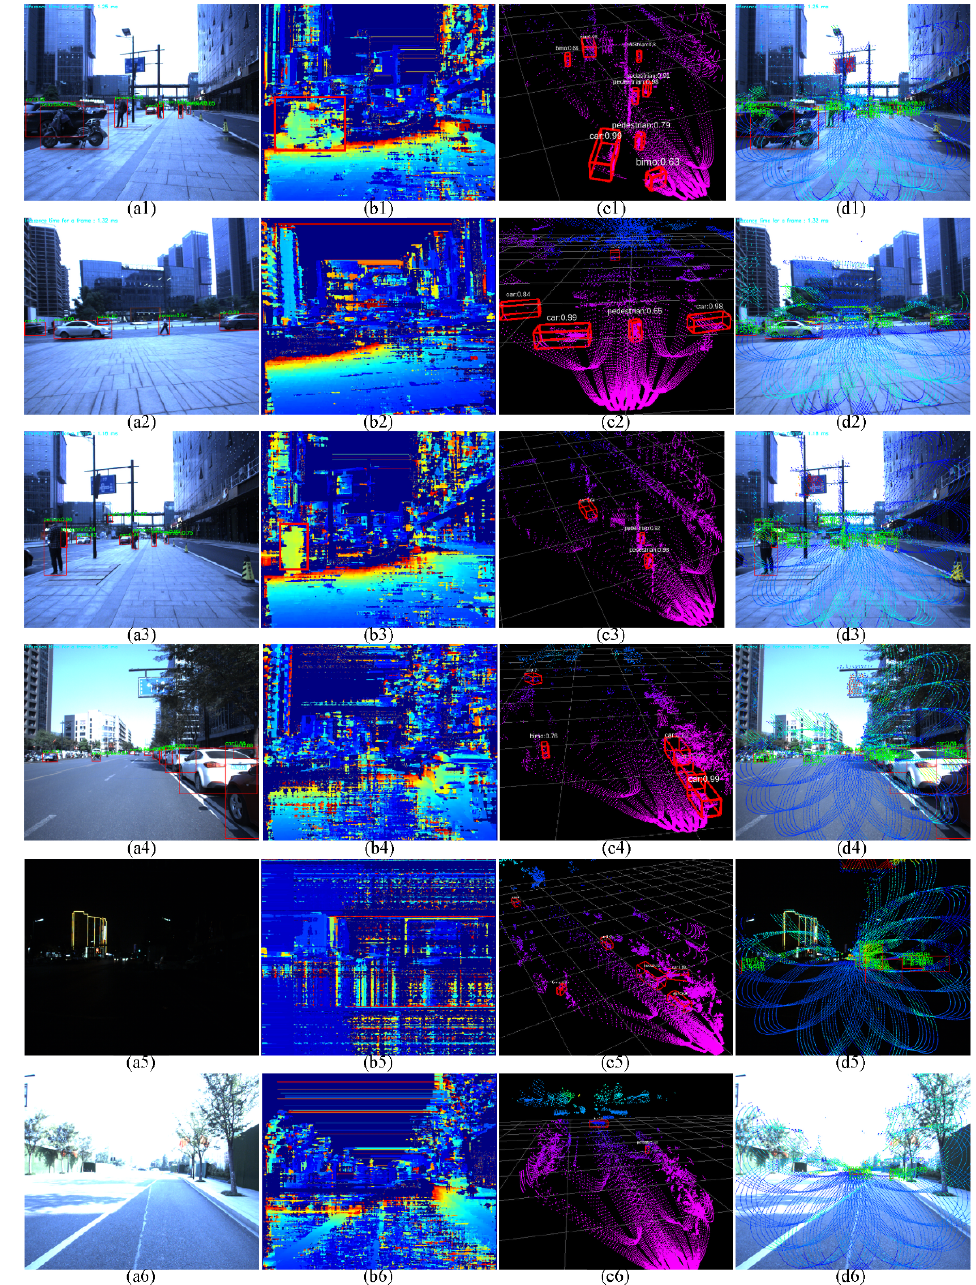
Figure 14. The objects detection and data fusion tests: ( a1 – a6 ) The color images with zero-degree polarization, and the object detection results using the YOLOv4 network. The detection and recognition results are labelled using the red bounding box. The class name and the confidence are put on the upper left corner of the bounding box. ( b1 – b6 ) The corresponding depth images, and the detection results using the MeanShift algorithm. The detection results are labelled using the red bounding box. ( c1 – c6 ) The LiDAR point cloud that is synchronized with the color image, and the detection results based on the PointPillars network. The results are labelled using the red 3D bounding box. The class name and the confidence are put on the upper left corner of the bounding box. ( d1 – d6 ) The data fusion results. The point cloud and the data fusion results are projected on the corresponding color image. The detected objects are labelled using the red bounding box. The class name, confidence and space coordinate are labelled on the upper left corner of the bounding